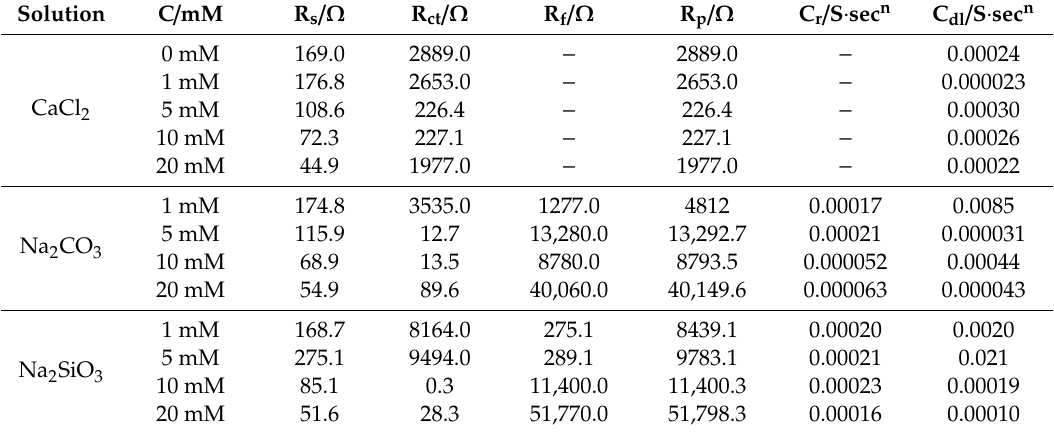
Figure 4. Equivalent electric circuits used to extract parameters from the EIS spectra. ( a ) SG + CaCl 2 ; ( b ) SG + Na 2 CO 3 ; ( c ) SG + Na 2 SiO 3 . (R s : electrolyte resistance; R ct : charge-transfer resistance; R f : film resistance; C dl : double layer capacitance; C f : film capacitance).